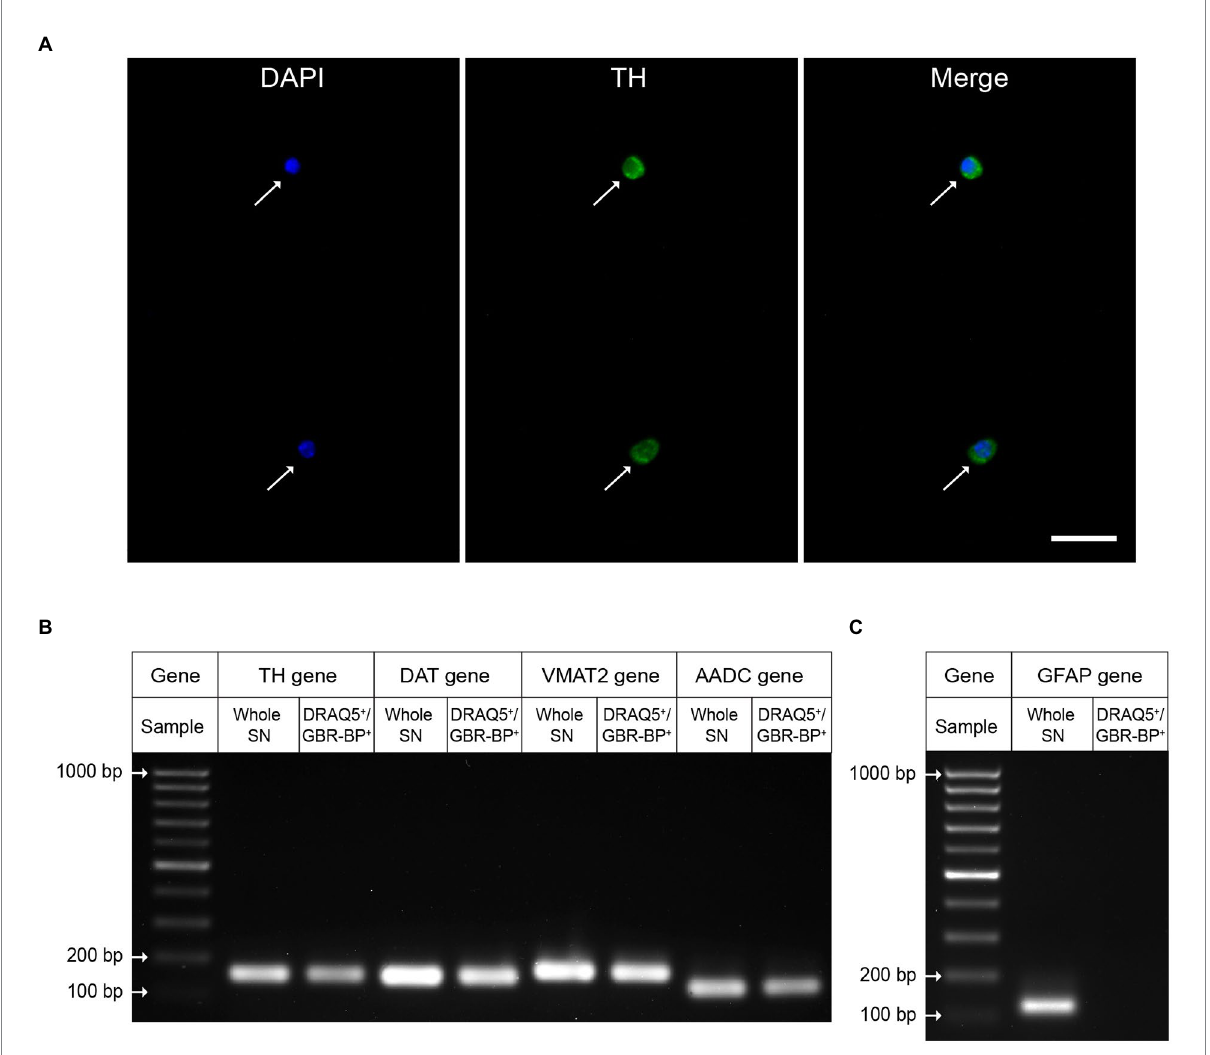
FIGURE 6 Evidence that the sorted population of double-stained cells (DRAQ5 + /GBR-BP + ) are dopaminergic neurons. (A) Tyrosine hydroxylase (TH)- immunopositive neurons (green) with 4 ′ ,6-diamidino-2-phenylindole (DAPI)-stained nuclei (blue) in the substantia nigra (SN) cell suspension sorted by two fluorescent markers, DRAQ5 and GBR-BP ( n = 3). Arrows, TH-immunopositive neurons. Scale bar, 20 μ m. (B) Expression of genes for protein markers of dopaminergic neurons: TH, dopamine transporter (DAT), vesicular monoamine transporter 2 (VMAT2), and aromatic L-amino acid decarboxylase (AADC) in DRAQ5 + /GBR-BP + cells sorted from a cell suspension of SN vibratome sections, as well as in the SN (homogenate) in intact mice ( n = 3). (C) Gene expression of the glial fibrillary acidic protein (GFAP) ( n = 3).